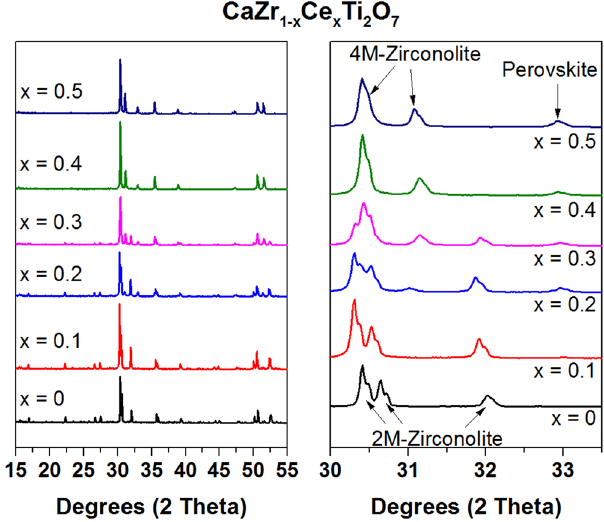
Figure 2. XRD patterns of Ce-zirconolites.